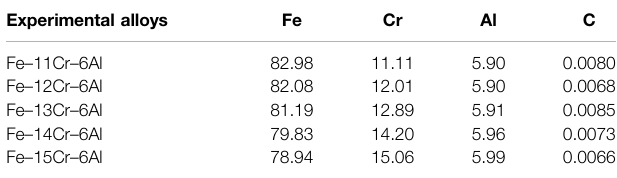
TABLE 1 | Chemical compositions of experimental of Fe – Cr – Al alloy